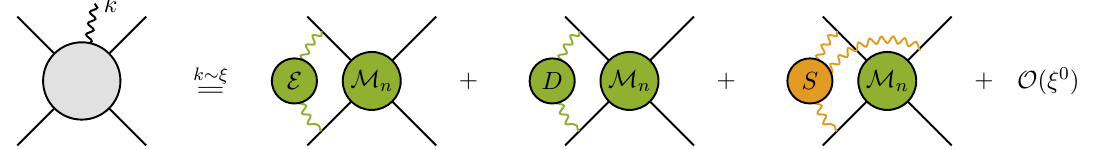
Figure 3 . Schematic illustration of the soft factorisation of (3.31) at subleading power and at one